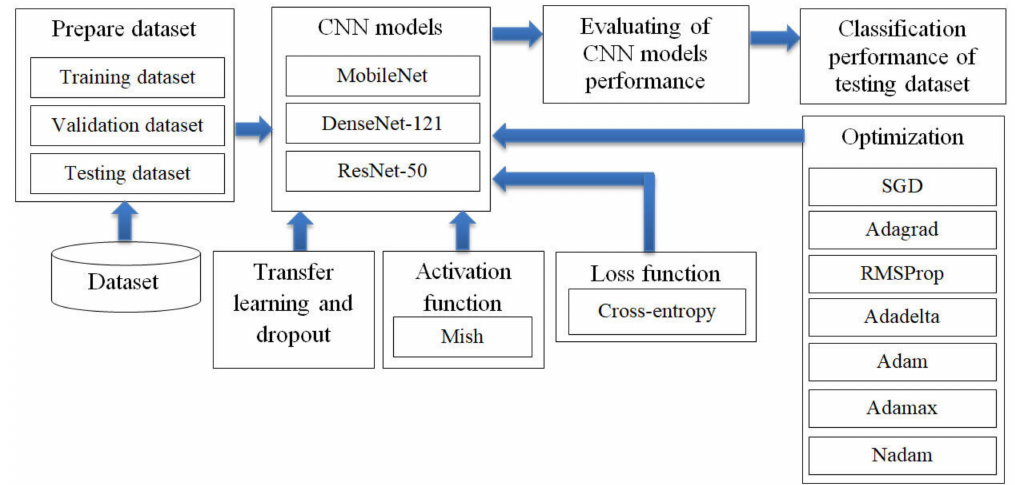
Figure 2. Research methodology: the optimization of convolutional neural network (CNN) models in predicting lung disease from chest X-ray images by using seven optimizer methods such as stochastic gradient descent (SGD).